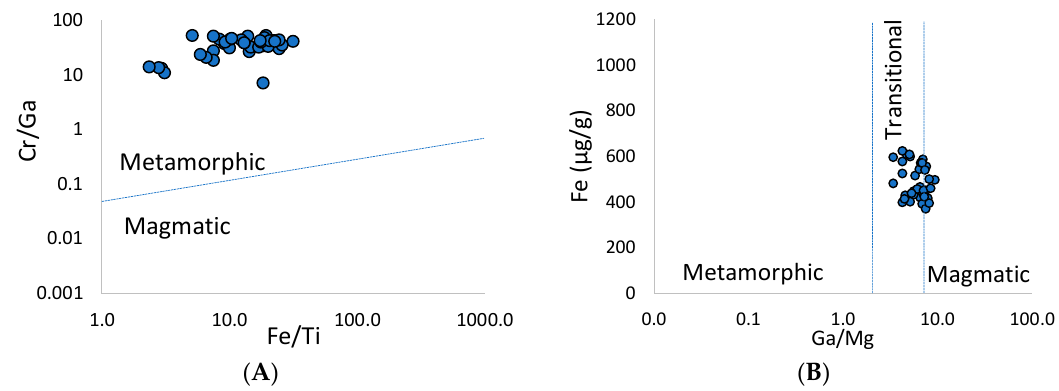
Figure 9. Cr/Ga vs. Fe/Ti plot of Snezhnoe ruby modified after [33] ( A ); Fe(µg/g) vs. Fe/Ti plot of Figure 9. Cr / Ga vs. Fe / Ti plot of Snezhnoe ruby modified after [33] ( A ); Fe( µ g / g) vs. Fe / Ti plot of Snezhnoe ruby modified after [32,33] ( B ). Snezhnoe ruby modified after [32,33] ( B